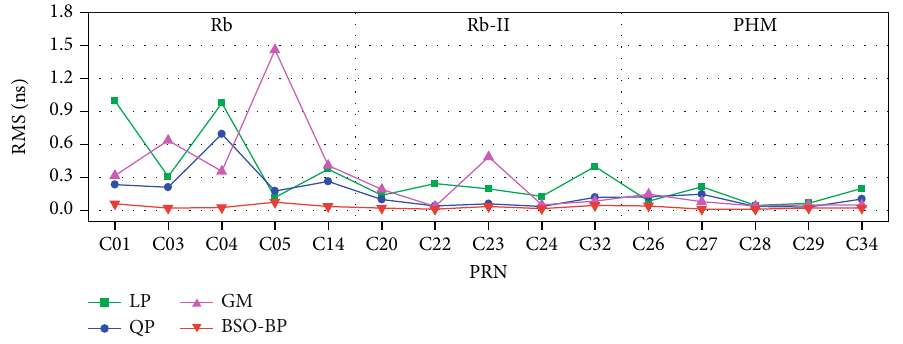
Figure 8: The prediction accuracy of 15 BDS satellites for 0.5 hours using 12 hours SCB data.